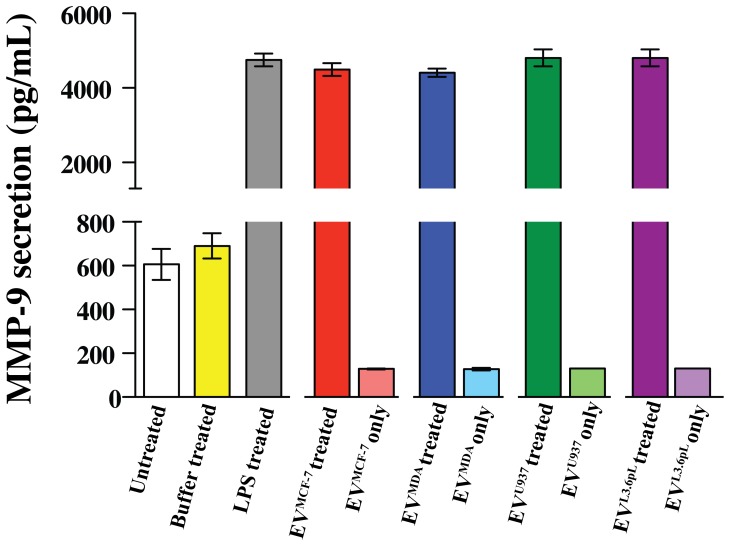
MMP-9 is secreted upon stimulation with EVs in THP-1 cells.MMP-9 secretion in THP-1 cells was measured with an ELISA assay upon stimulation with EVMCF-7, EVMDA, EVU937 and EVL.6pL. The EVs themselves secrete low levels of MMP-9 that did not contribute significantly to the overall observed secreted MMP-9 levels.